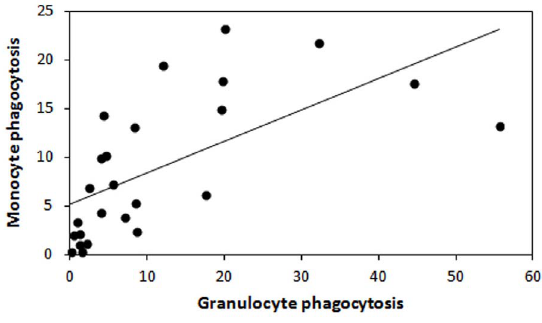
Figure 1. Regression line between monocytes and granulo- cytes phagocytosis of 14 days-old nestlings spotless